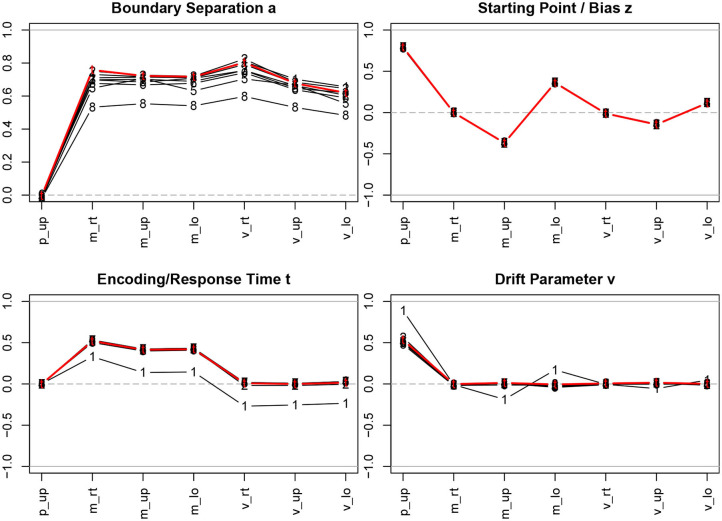
Correlation coefficients of descriptive statistics with the parameter estimates. The bold (red) lines indicate the correlations with the true parameter values; the estimation methods are indicated by numbers, 1 = R-EZ, 2 = R-BY, 3 = R-BF, 4 = R-NL, 5 = R-NM, 6 = F-ML, 7 = F-KS, 8 = F-CS; p_up, proportion of upper boundary crossings; m_rt, mean response time; m_up, mean response time for upper boundary crossings; m_lo, mean response time for lower boundary crossings; v_rt, variance of response time; v_up, variance of response time for upper boundary crossings; v_lo, variance of response time for lower boundary crossings.